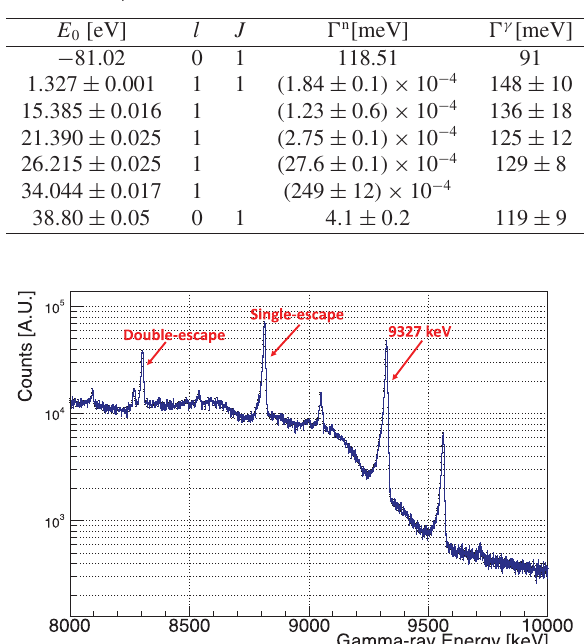
Figure 1. Gamma-ray spectrum due to neutron capture in the target, shown for the range 8 – 10MeV. The peak with an energy of 9327keV and its single- and double-escape peaks due to 117 Sn in the target can be observed clearly.